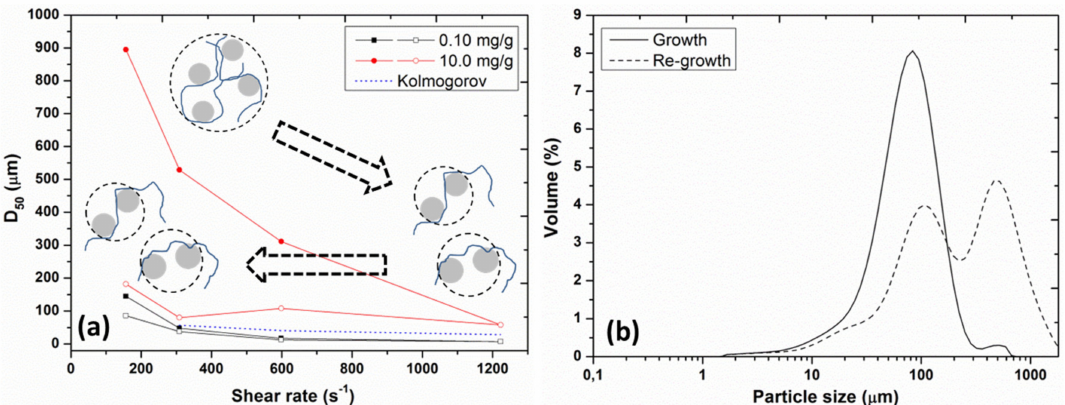
Figure 8. ( a ) Variation of equilibrium (steady state) floc size (D 50 ) as a function of shear rate for clay concentration of 0.7 g / L with di ff erent amounts of cationic flocculant. The filled symbols indicate the flocs created at the onset of experiments whereas the open symbols indicate the flocs already experienced shearing action. The dashed line presents the Kolmogorov length scale, ( b ) particle size . γ = distribution for 10 mg / g flocculant to clay ratio at a steady state (t = 9000 s) for 600 s − 1 during the . γ = growth phase and for 300 s − 1 (t = 3000 s) during the regrowth